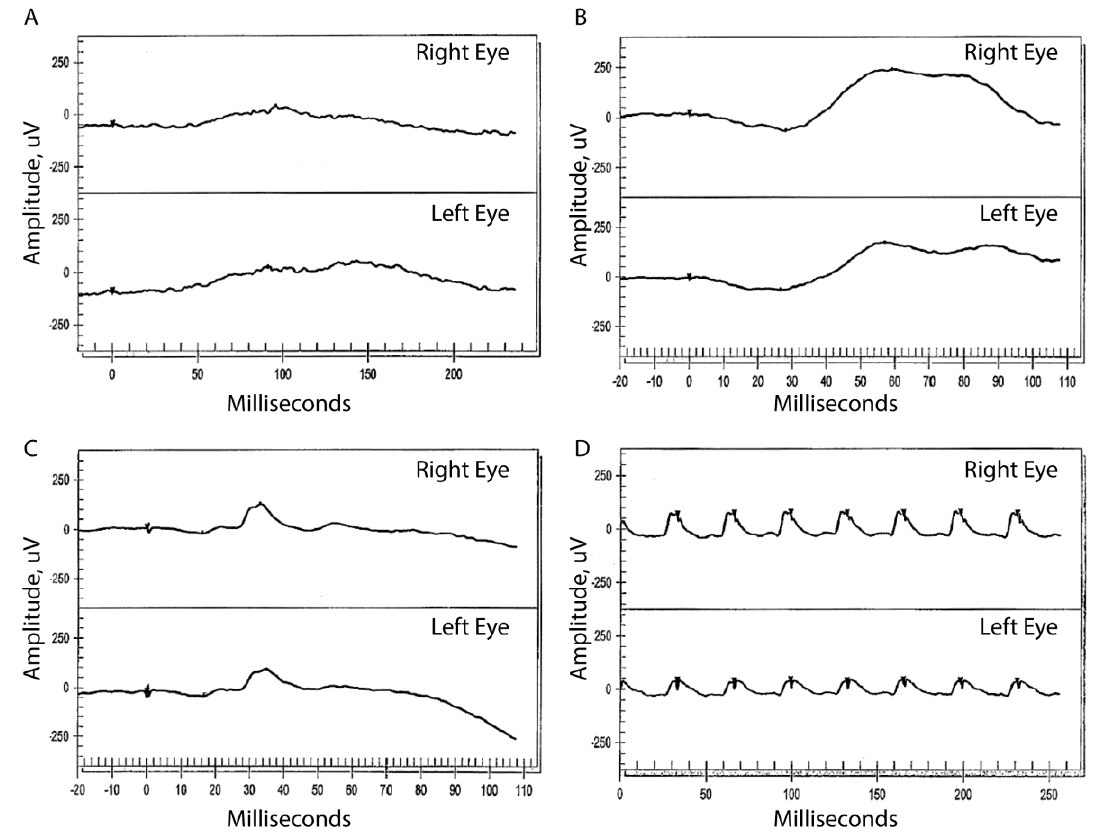
Figure 4. Electroretinogram (ERG). ERG responses from II:3 at age 47 show moderately reduced but measureable amplitudes in both eyes in response to ( A ) dim ( − 24 dB) scotopic flash; ( B ) mixed (0 db) scotopic flash; ( C ) single 0 dB photopic flash; and ( D ) 30 Hz 0 dB flicker